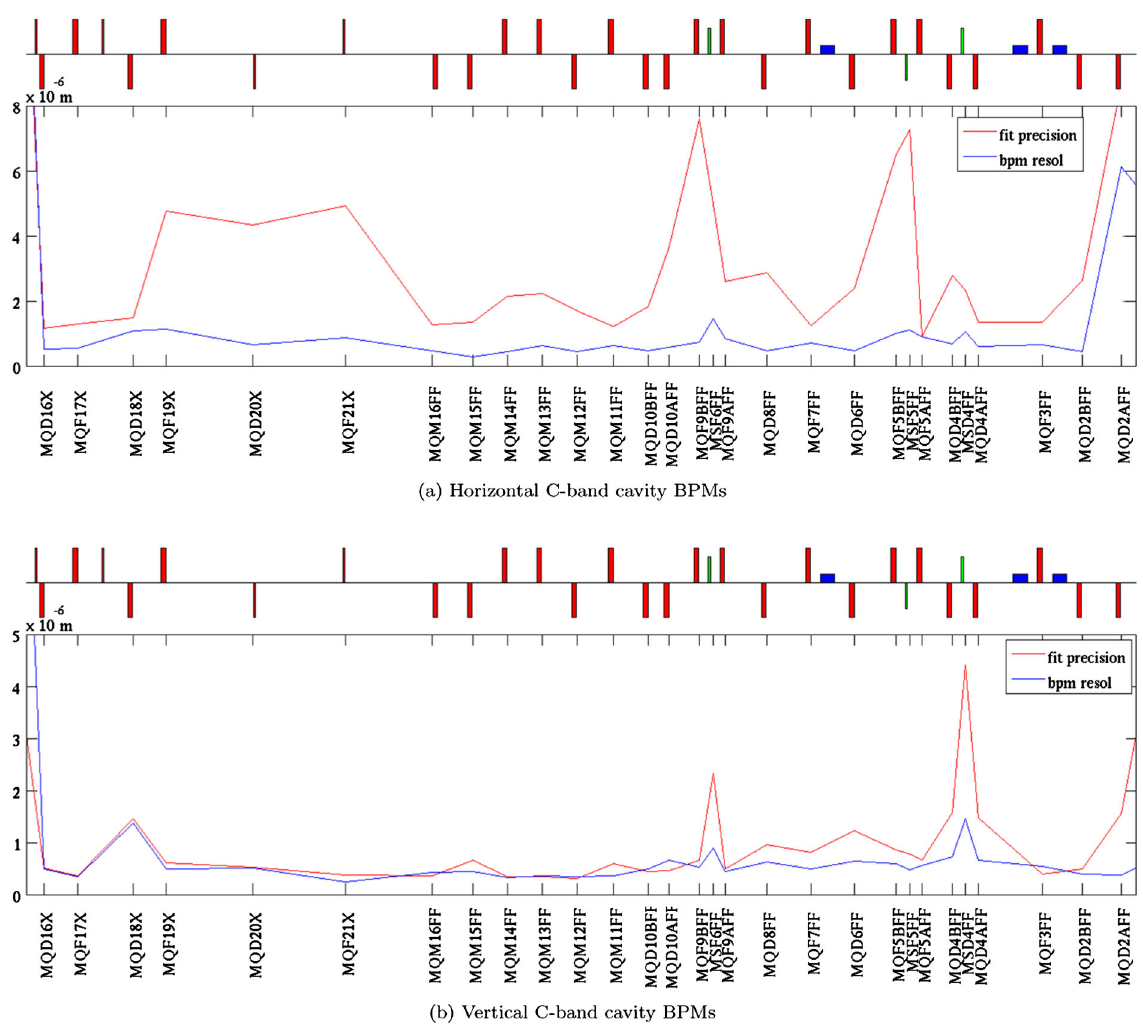
FIG. 4. Horizontal and vertical resolution of the BPMs along with the fit resolution.